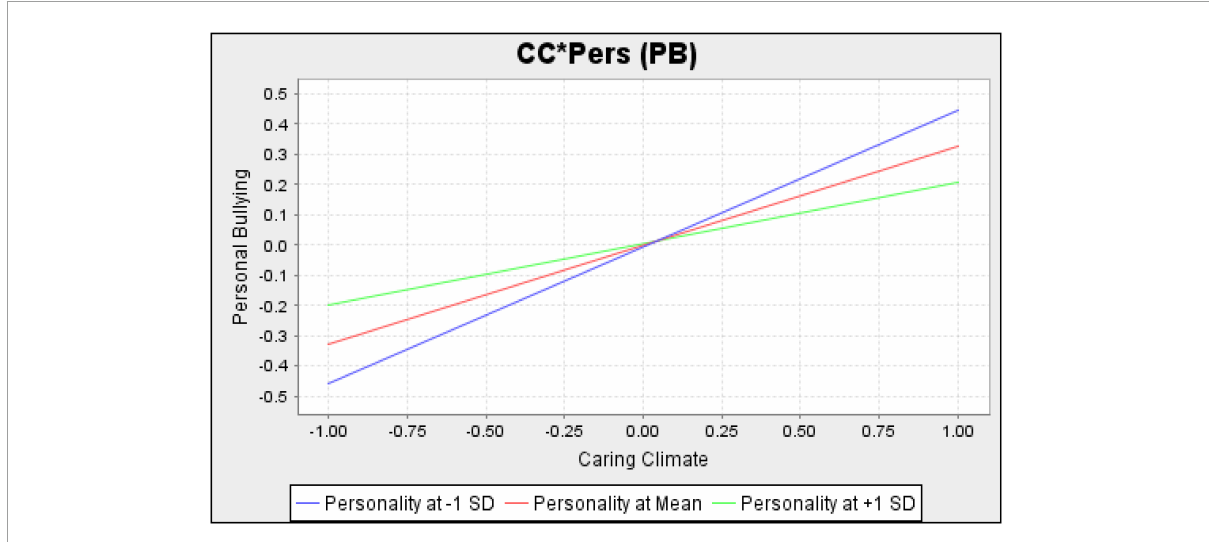
FIGURE3 Personality as a moderator between a caring climate and personal